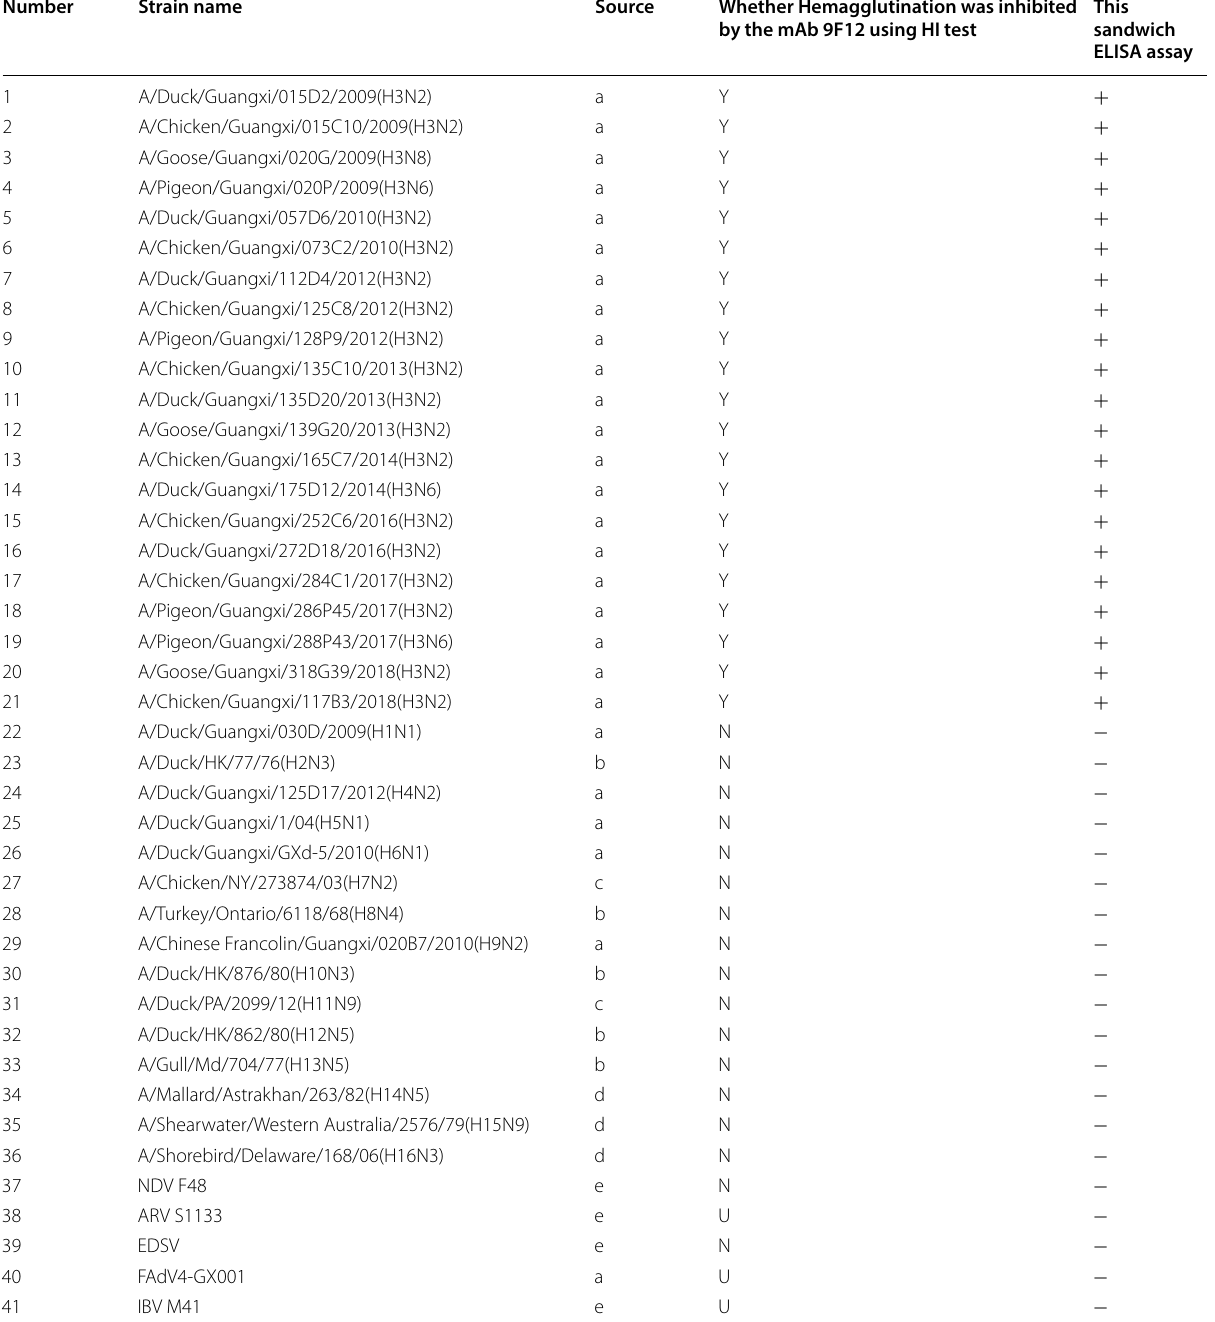
Table 1 Origins of the H3-subtype AIV isolates used in this